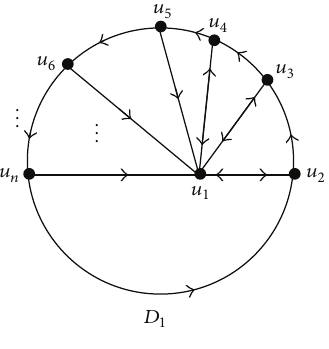
Figure 1: The digraphs 𝐷 1